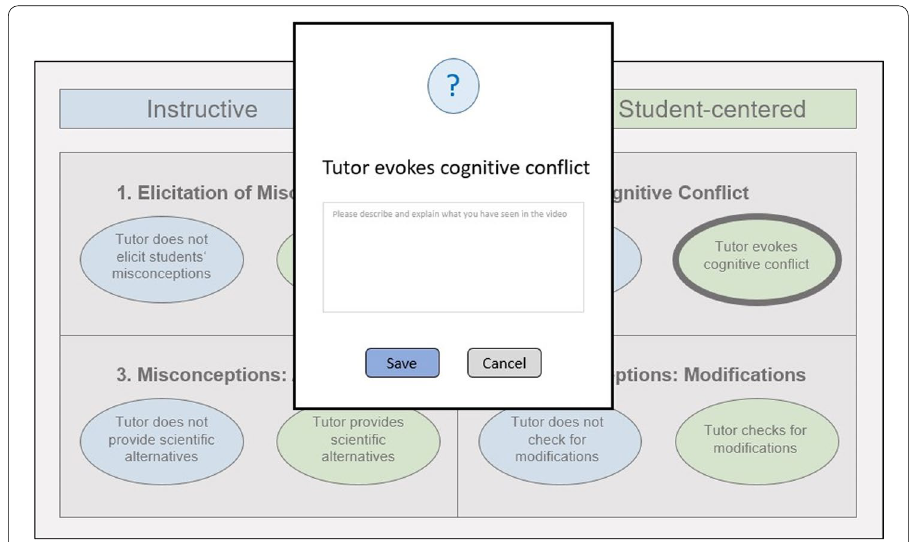
Fig. 3 Analysis Task Display in the Focused-Prompts Condition . This figure (in a non-interactive version) was presented to all participants as an overview in the introductory texts. In the focused-prompts condition, participants additionally received this interactive version in which they could add examples from the training phase